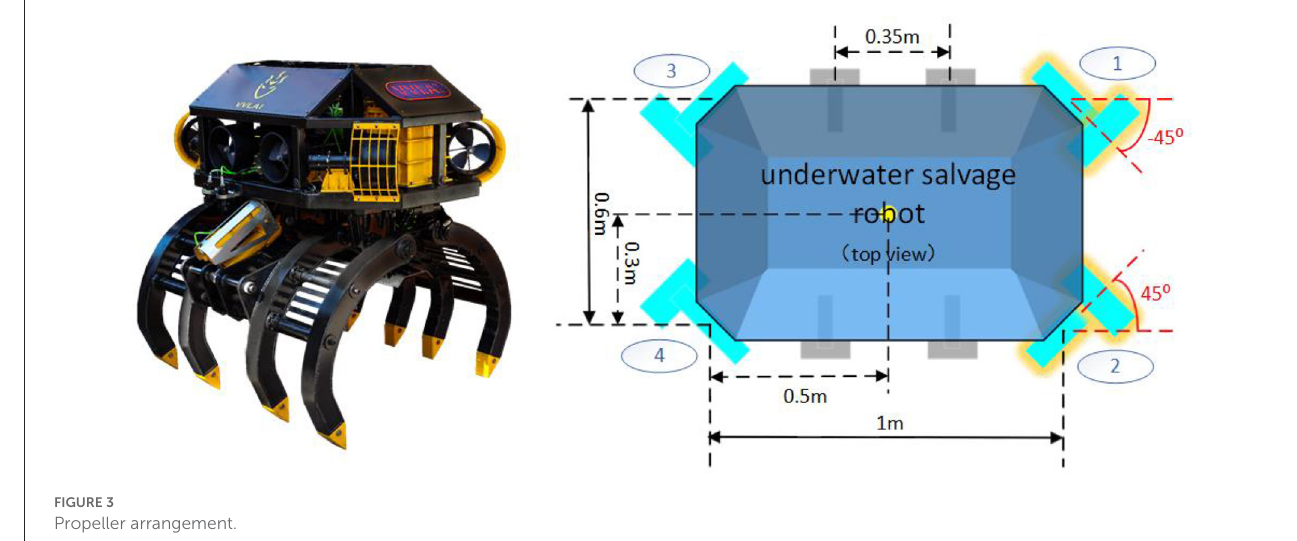
FIGURE3 Propeller arrangement.